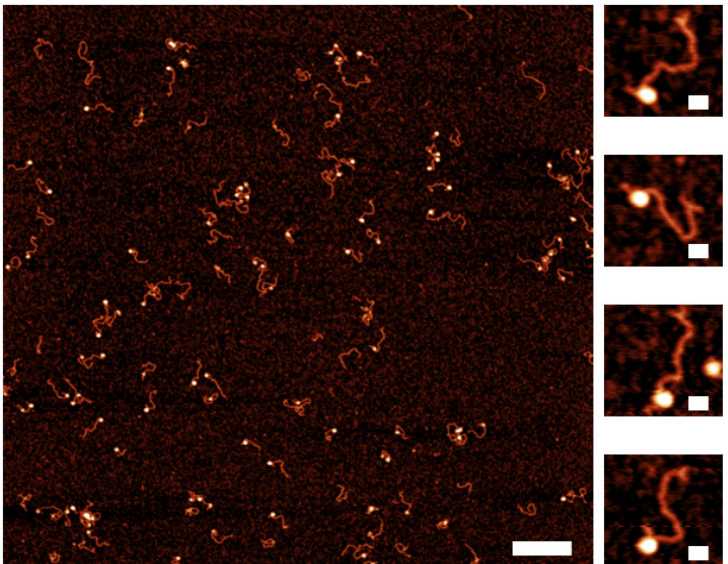
Figure 6. AFM images of dried nucleosome sample assembled on a dinucleosome construct containing the Widom 601 sequence. The snapshots display nucleosomes bound to the Widom 601 sequence and a clear 3WJ. The scale bars are 300 nm and 25 nm for the larger image and snapshots, respectively.